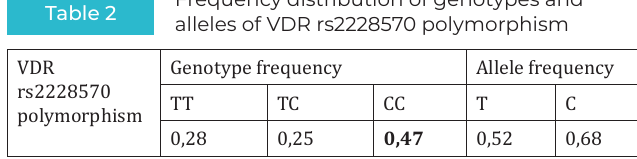
Frequency distribution of genotypes and alleles of VDR rs2228570 polymorphism